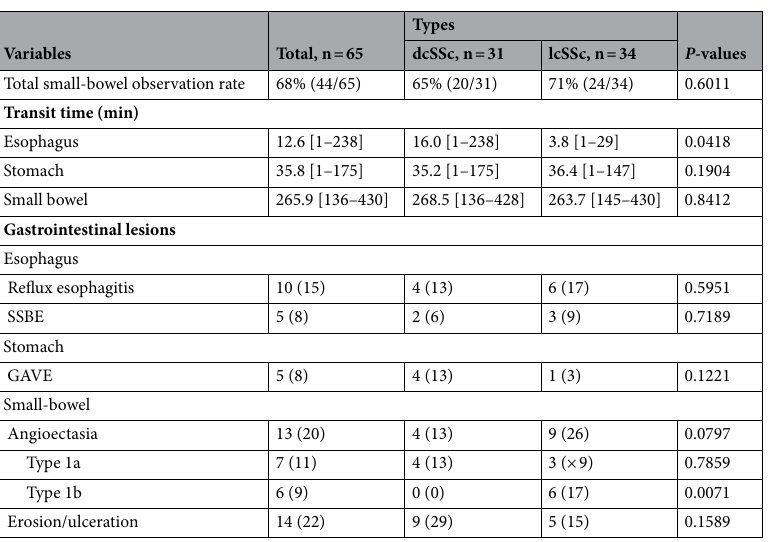
Table 2. The average capsule transit time and gastrointestinal lesions in patients with systemic sclerosis. Data are shown as frequencies (percentages) or means, as appropriate. SSc: systemic sclerosis, dcSSc: diffuse cutaneous SSc, lcSSc: limited cutaneous SSc, SSBE: short-segment Barret’s esophagus, GAVE: gastric antral vascular ectasia.